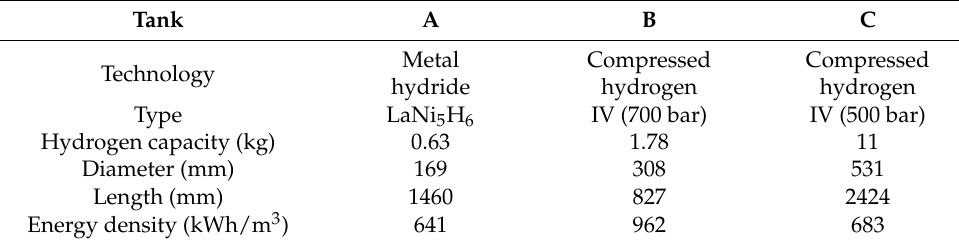
Table 2. Technical characteristics of the different types of hydrogen storage tanks considered. Tank A B C Metal Compressed Compressed Technology hydride hydrogen hydrogen Type LaNi 5 H 6 IV (700 bar) IV (500 bar) Hydrogen capacity (kg) 0.63